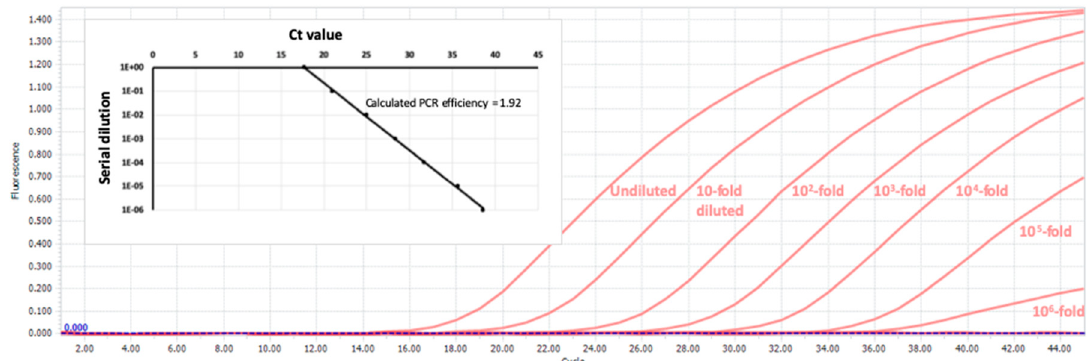
Figure 4. SARS-CoV-2 PCR amplification curves from successive 10-fold dilutions of a positive sample.